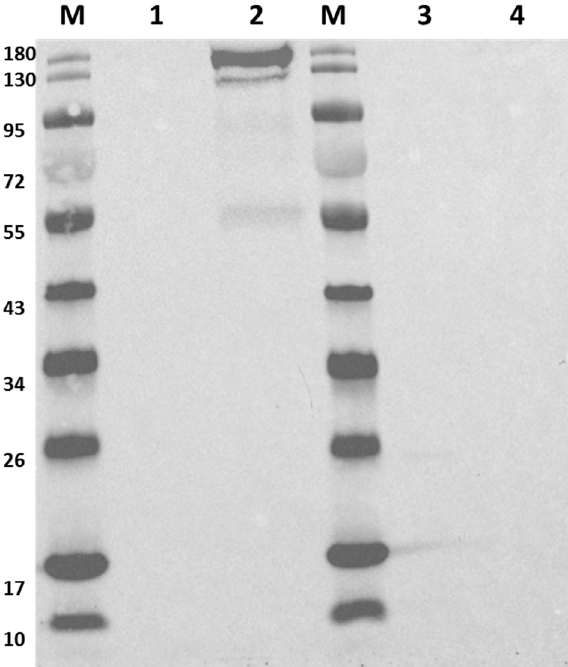
Figure 2. Western blot analysis of cas9 expression in C. acetobutylicum strains MGC Δ cac1502 and CAS1. The strains were grown in Clostridium growth medium (CGM) liquid media with either glucose or xylose as the sole carbon source; the cell pellet was then subjected to an SDS-PAGE/Western blot using an antibody raised against Cas9 (Abcam). M: marker, 1: strain CAS1 grown on glucose, 2: strain CAS1 grown on xylose, 3: strain MGC Δ cac1502 grown on glucose, 4: strain MGC Δ cac1502 grown on xylose. The expected molecular weight of Cas9 is 160 kDa.